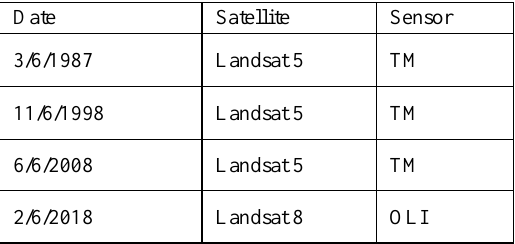
Table 1. Landsat satellite images